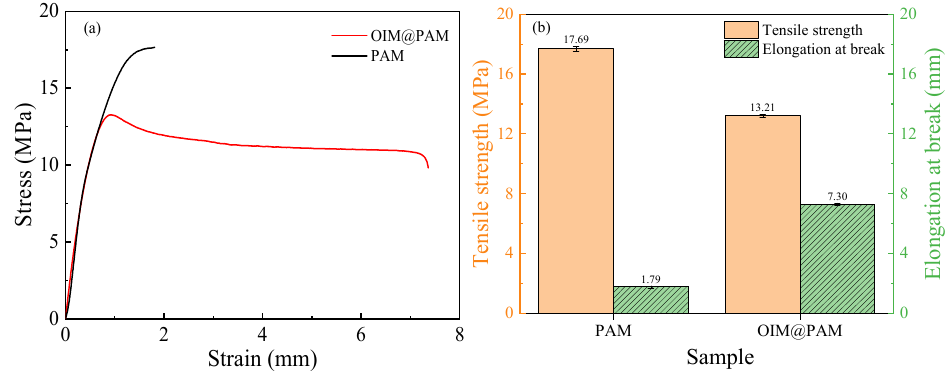
Figure 4. ( a ) Tensile stress–strain curve of PAM and OIM@PAM after vacuum-drying for 24 h at 45 °C; ( b ) the values of the tensile strength and the elongation at break of OIM and OIM@PAM.